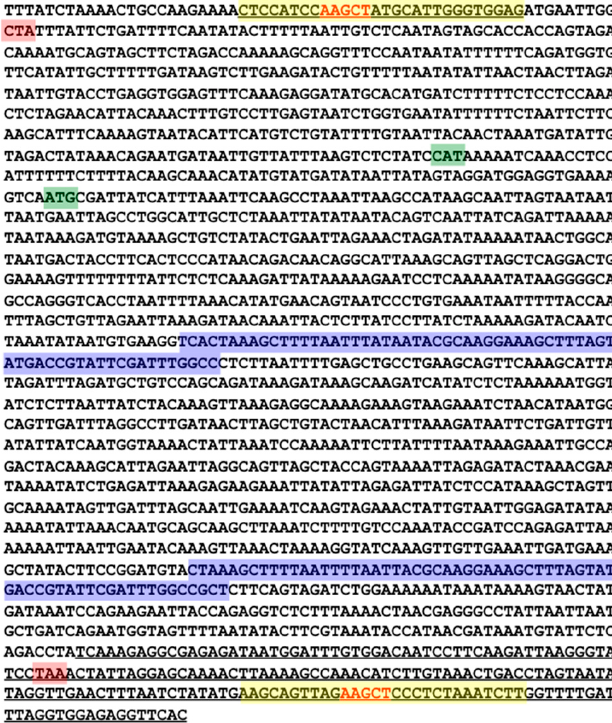
Figure 4. Locus 09 as a representative of a complete IS605 element in H. hydrogeniformans . The sequence shown is the tnpB coding strand and organized from 5’ to 3’. Start and stop codons are highlighted in green and red respectively. The tnpA and tnpB open reading frame (ORF) are in divergent orientation, with tnpA shown towards the 5’ end of the representative element. The tnpB ORF left and right inserts are highlighted blue. The left end and right end structure 2 stem-loop sequences are highlighted in yellow. An AAGCT pentanucleotide sequence in the loops of the left end structure and right end structure 2 are bolded in red text. The underlined sequences correspond to the sequence of the PATE-like element.